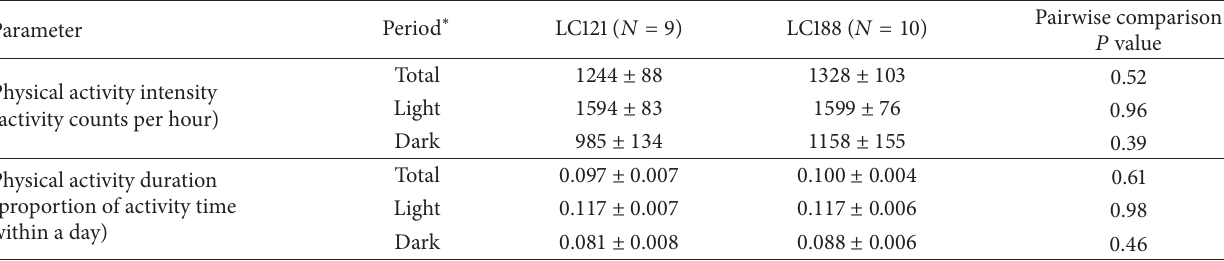
Table 4: Adjusted means ( ± SEM) for physical activity in adult cats fed LC121 and LC188 supplemented diets above maintenance energy requirements.